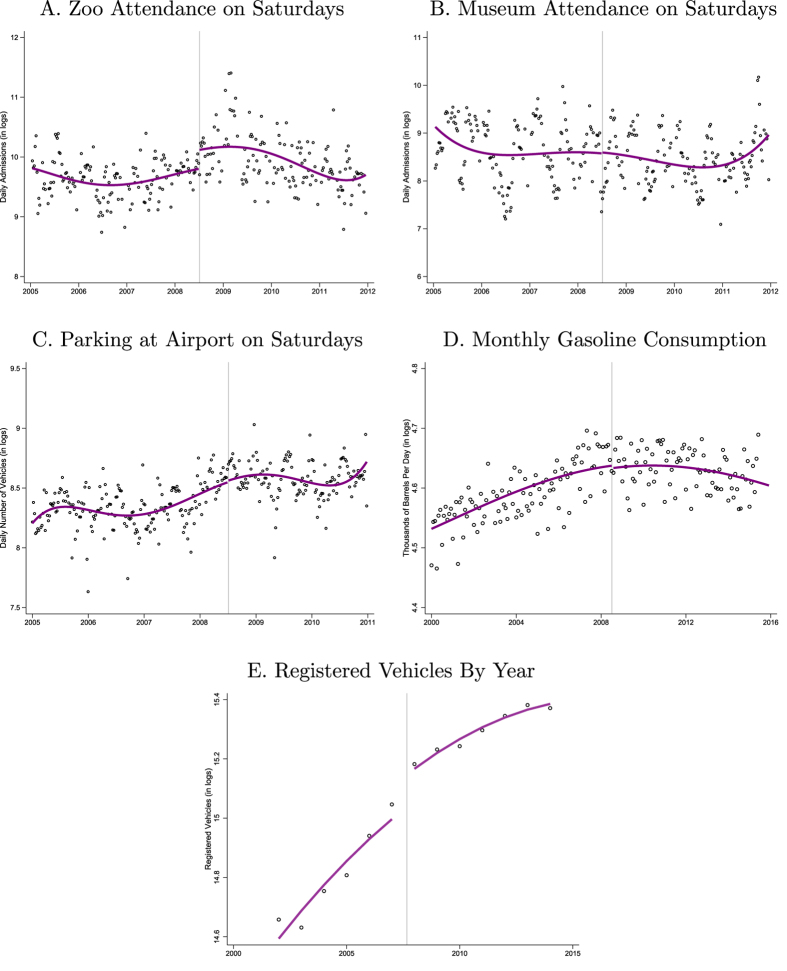
Additional Evidence.